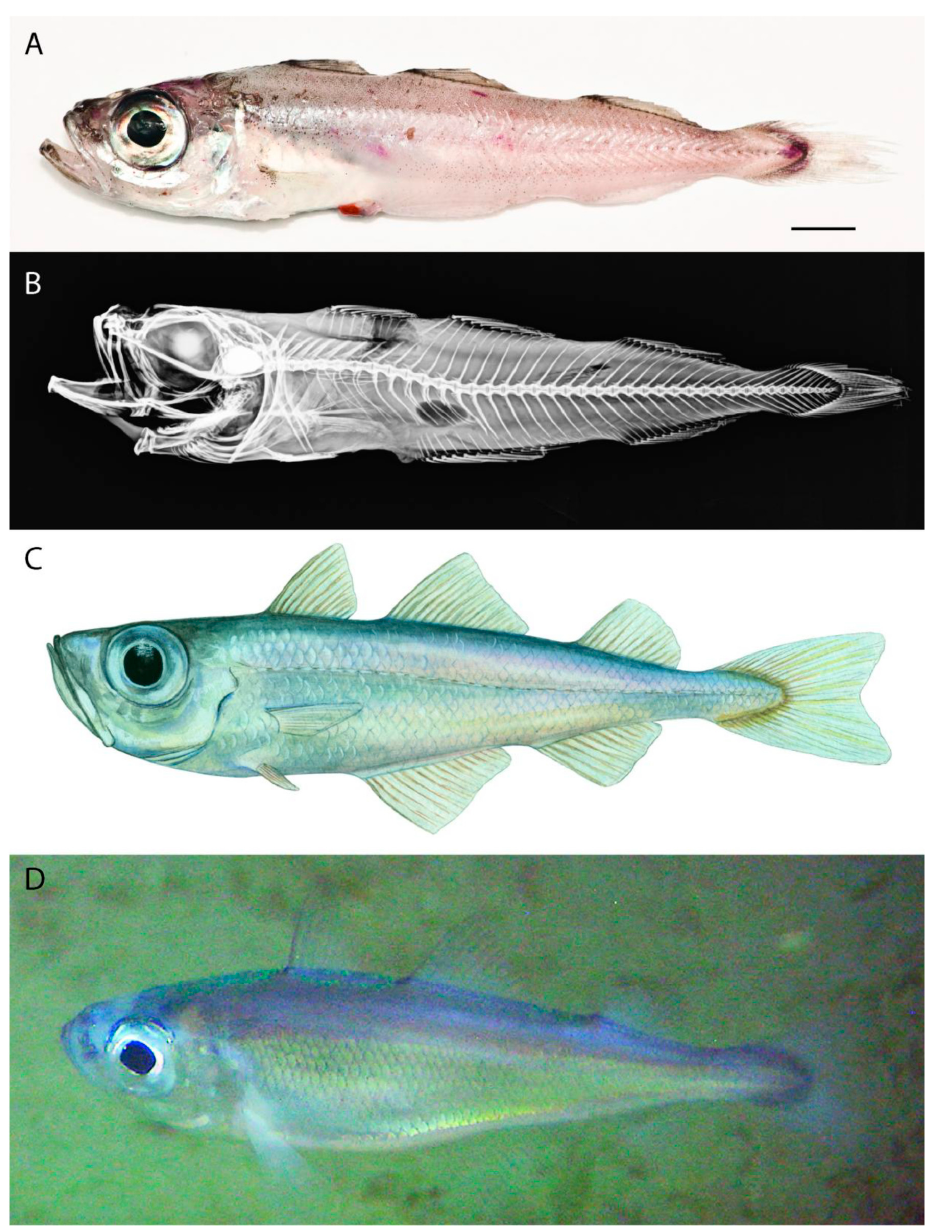
Figure 2. Gadiculus thori . ( A ). ZMUB 14683 (registration number of Museum of Zoology, University of Bergen, Norway). Newly caught off Southeast Greenland in 2012, providing a range expansion into the northwestern Atlantic (Photo: Greenland Institute of Natural Resources, Greenland). Scale bar: 10 mm; ( B ). X-ray of ZMUB 14683. Meristics and morphometrics presented in Table 2; ( C ). Gadiculus thori newly illustrated for this study; ( D ). Live specimen G. thori (67°48 ′ N, 10°54 ′ E) at 227 m depth filmed during the MAREANO expedition off Arctic Norway in 2011.